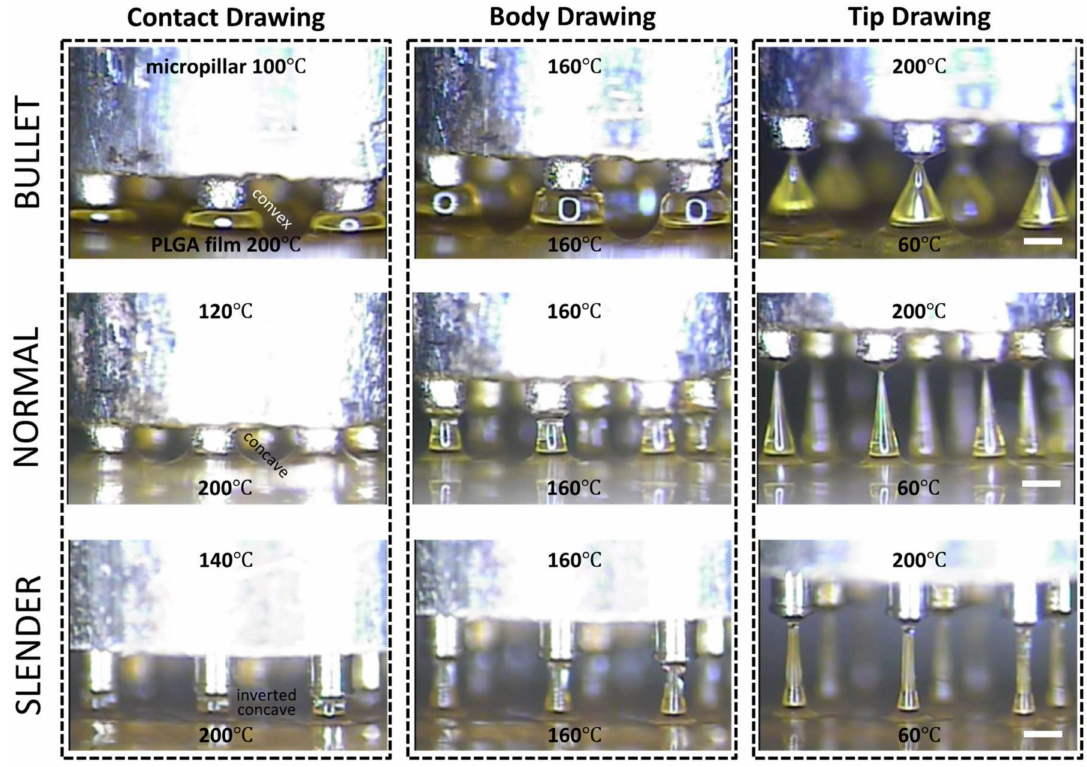
Figure 4. Representative images of shape control for 650 µ m height poly(lactic-co-glycolic)acid 90:10 microneedle array with normal (aspect ratio (A/R) = 3.5), bullet (A/R = 1.5), and slender (A/R =